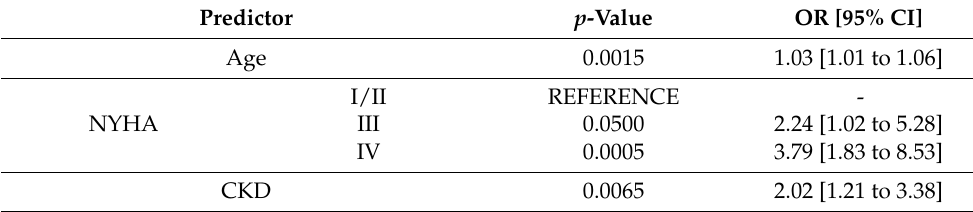
Table 4. Independent predictors of mortality in patients with